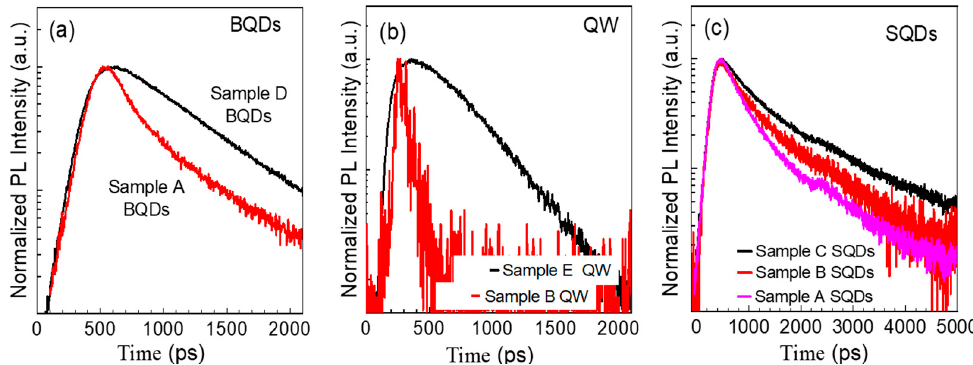
Figure 6. TRPL spectra measured at 10 K for ( a ) BQDs, ( b ) QW, and ( c ) SQDs, respectively.